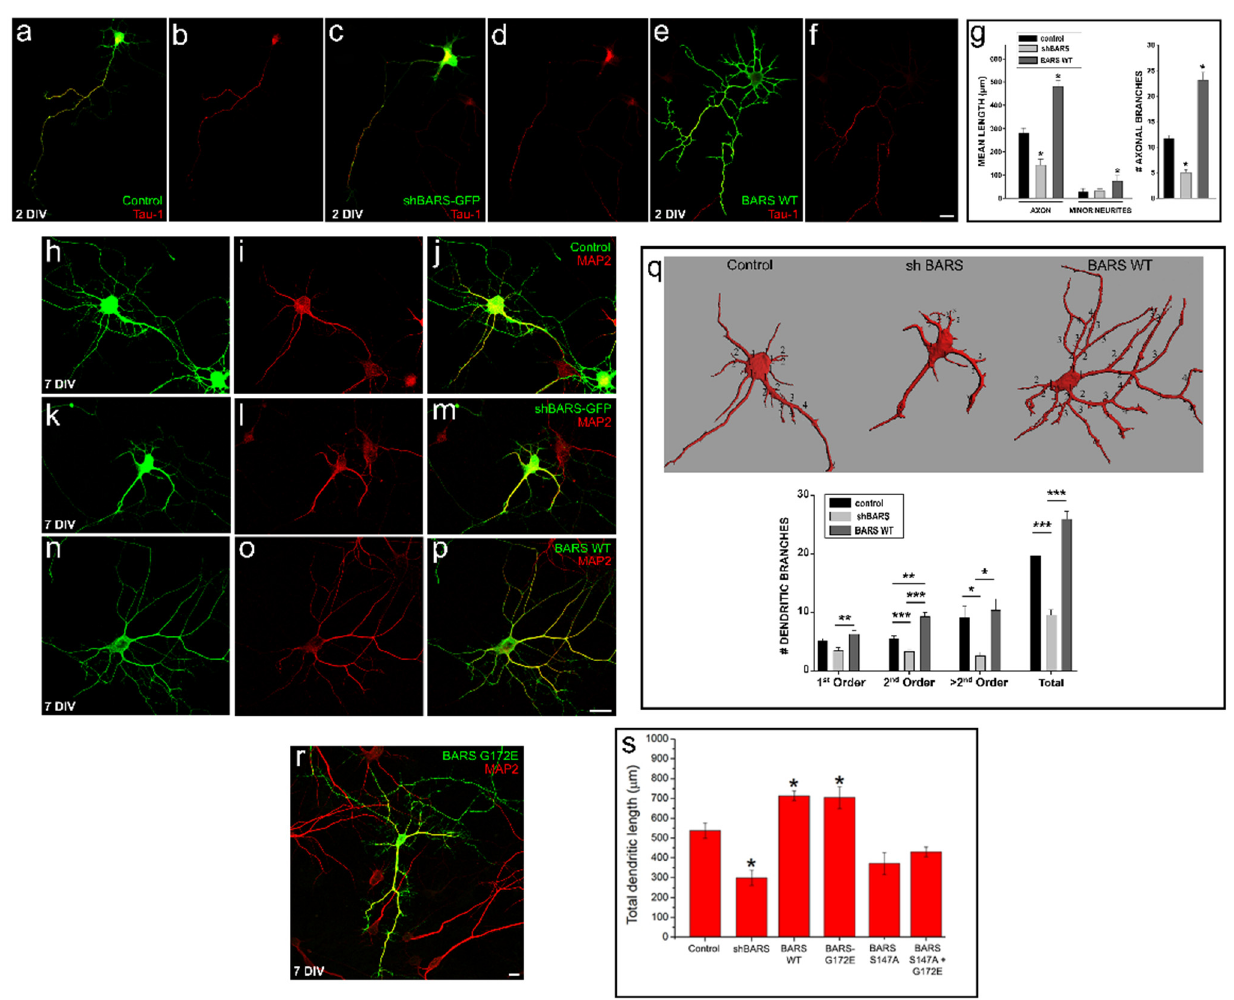
Figure 2. BARS regulates axon and dendrite growth in cultured neurons. ( a – f ) Confocal images showing the morphology of cultured hippocampal neurons (2 DIV) transfected with sc-shRNA- BARS-GFP (control), sh-RNA-BARS-GFP (shBARS-GFP), or BARS WT. Cultures were transfected shortly after plating, fixed 48 h later, and stained with the mAb Tau-1 (red) and a polyclonal Ab against BARS protein (green, in ( e )). Scale bar: 10 µm. ( g ) Graph showing quantification of total axonal and minor neurite lengths (left panel) and the number of axonal branches (right panel) after up- or down-regulation of BARS expression. Graphs represent mean ± S.E.M.; * p < 0.05; one-way ANOVA and Tukey’s post hoc test. ( h – p ) Confocal images showing dendritic morphology of cultured hippocampal neurons (7 DIV) transfected with sc-shRNA-BARS-GFP (control), sh-RNA-BARS-GFP (shBARS-GFP) or BARS WT. Cultures were transfected 5 days after plating, fixed 48 h later, and stained with an mAb against MAP2 (red) and a polyclonal Ab against BARS protein (green, in ( n – p )). Scale bar: 10 µm. ( q ) Three-dimensional reconstruction images (upper panel) and quantification of dendritic branches (lower panel) of the transfected neurons shown in ( h , k , n ). Graphs represent mean ± S.E.M.; * p < 0.05, ** p < 0.01, *** p < 0.001; one-way ANOVA and Tukey’s post hoc test. ( r ) Confocal image of a cultured neuron transfected with the BARS mutant G172E + GFP and stained with the mAb Tau-1. Scale bar: 10 µm. ( s ) Graph showing quantification of total dendritic length after up- or down-regulation of BARS levels or expression of BARS mutants. Graphs represent mean ± S.E.M.; * p < 0.05; one-way ANOVA and Tukey’s post hoc test. For all experiments, 9 to 15 neurons were quantified pooled from at least three independent cultures.